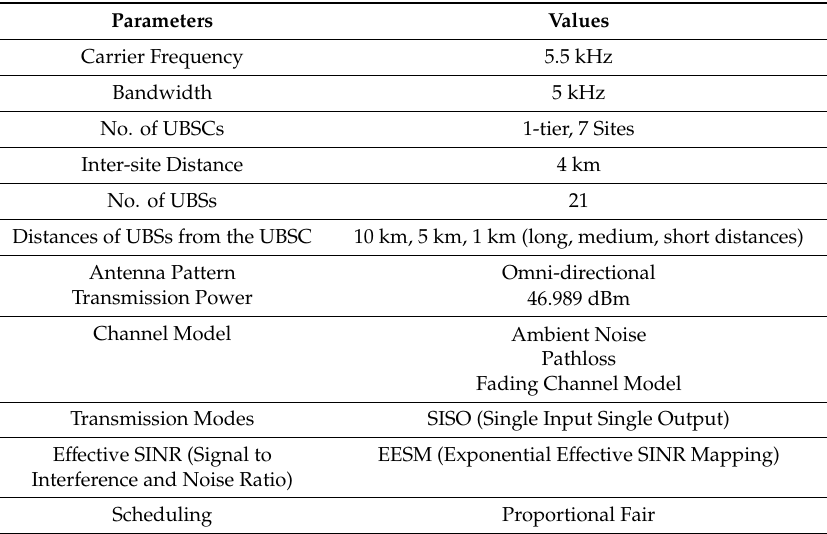
Table 2. System-level simulation